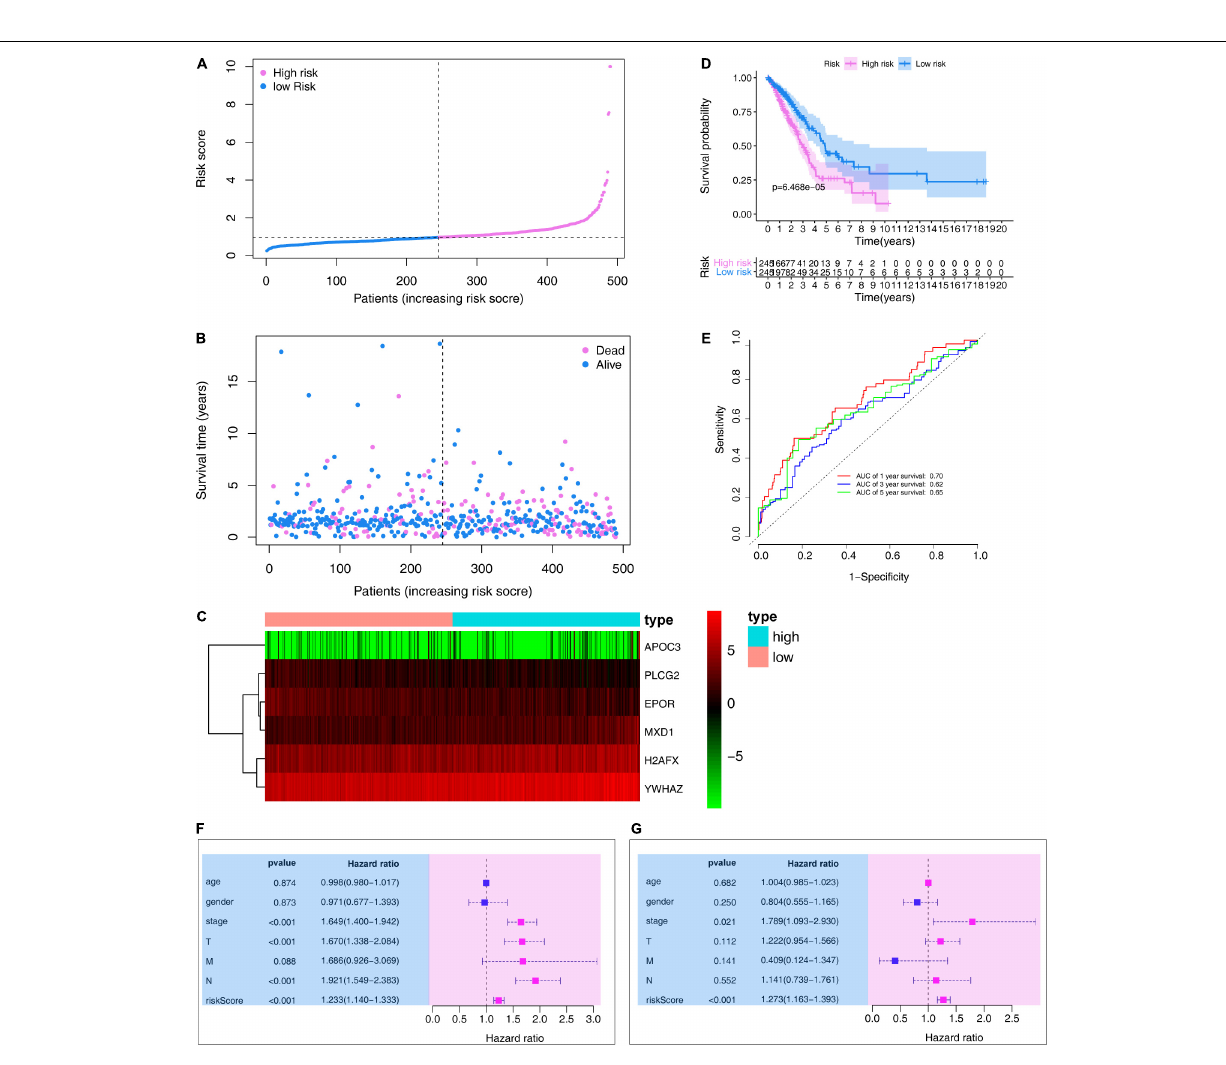
Frontiers in Cell and Developmental Biology |